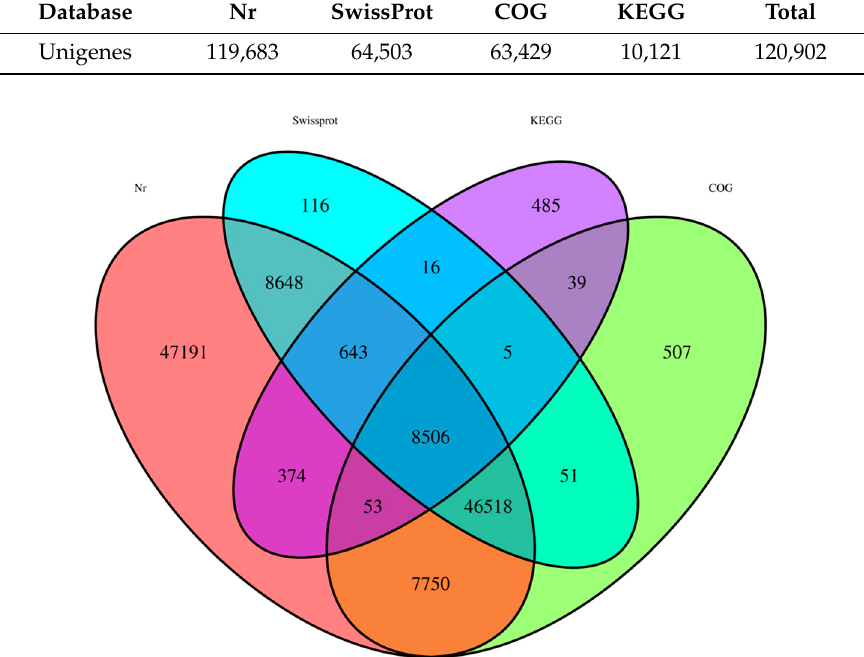
Figure 3. Comparison of unigene annotation in the National Center for Biotechnology Information (NCBI) non-redundant (Nr), SwissProt, Clusters of Orthologous Groups (COG), and Kyoto Encyclopedia of Genes and Genome (KEGG) databases.